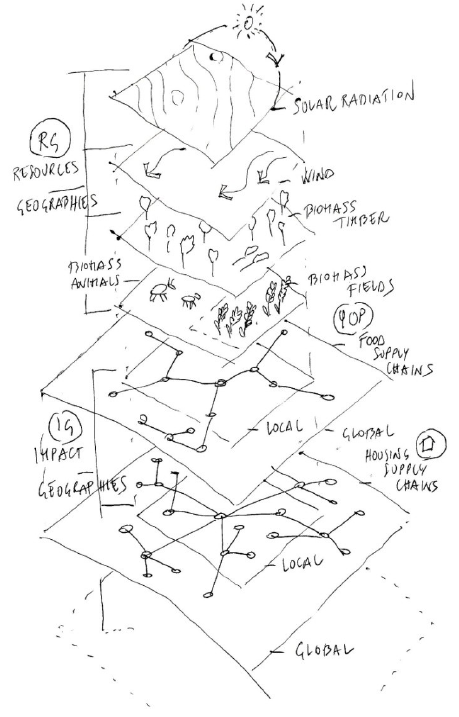
Figure 1 . Example image representing Resource geographies (RG) and Impact Geographies (IG) in the same